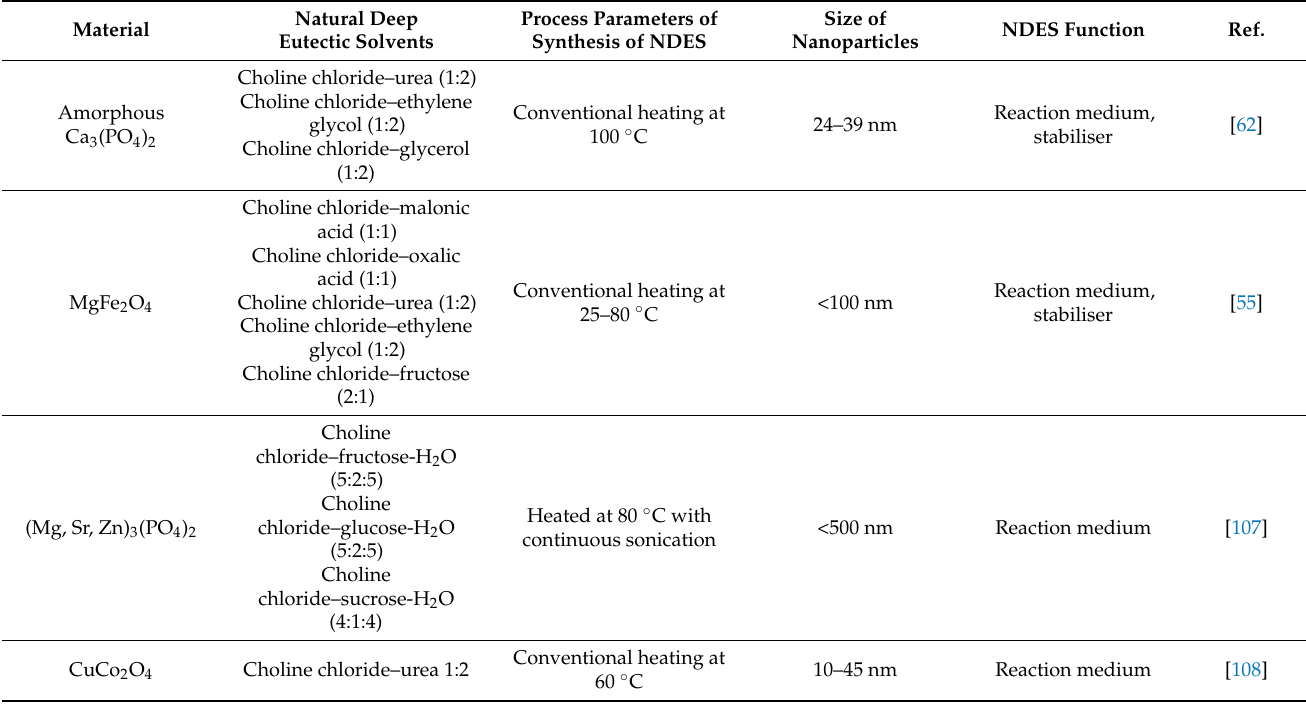
Table 4. Inorganic nanoparticles obtained using NDESs with a description of the method of obtaining NDESs and the functions they perform in the